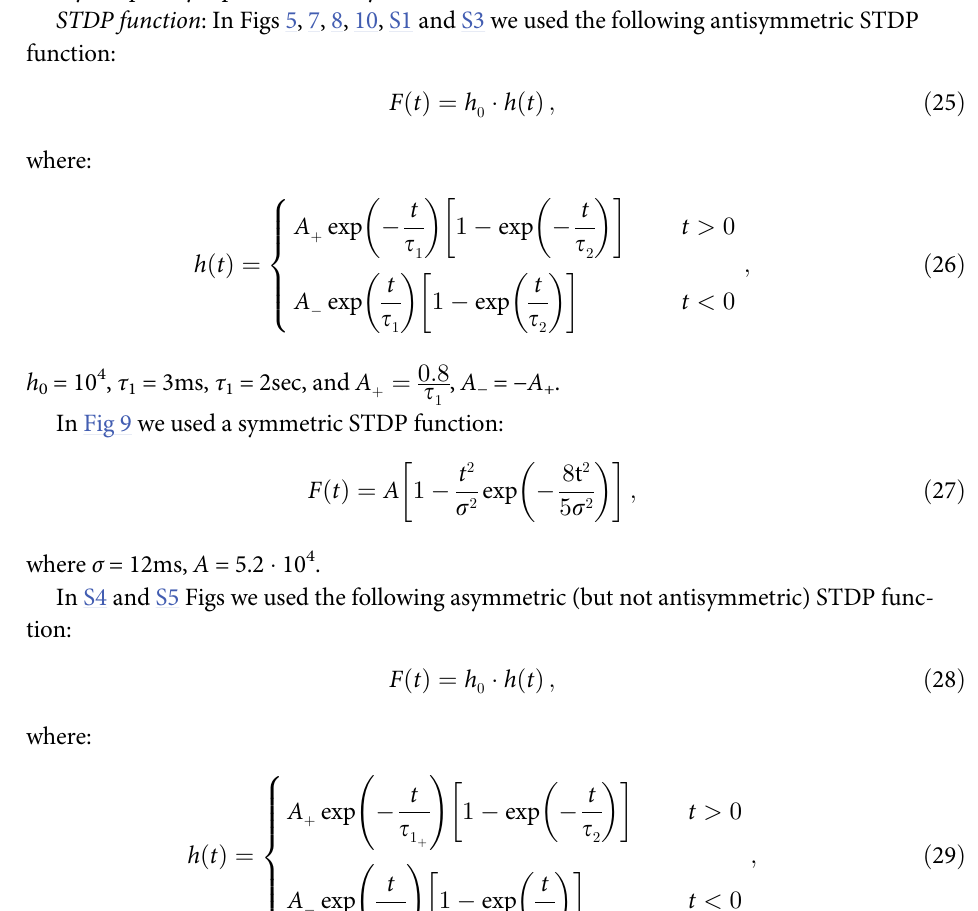
Table 1. The coefficients f α , β in Figs 4, 6 and S2. f 1,0 − f Fig 4C 1 − 1 1 − 1 0 left panel: 0 2,1 right panel: 16 Fig 4D 0.25 0.25 0 0 left panel: 0 0 0 right panel: 1.8 Fig 6A * * 0 0 0 20 − 20 Fig 6B * − 30 0 0 0 * − f 2,1 S2A Fig − 2 − 30 * − f 2,0 0 * − f 2,1 S2B Fig − 2 − 30 0 0 * * − f 2,1 S2C Fig * * 0 0 0 20 − 20 * Values are speci fi ed in the